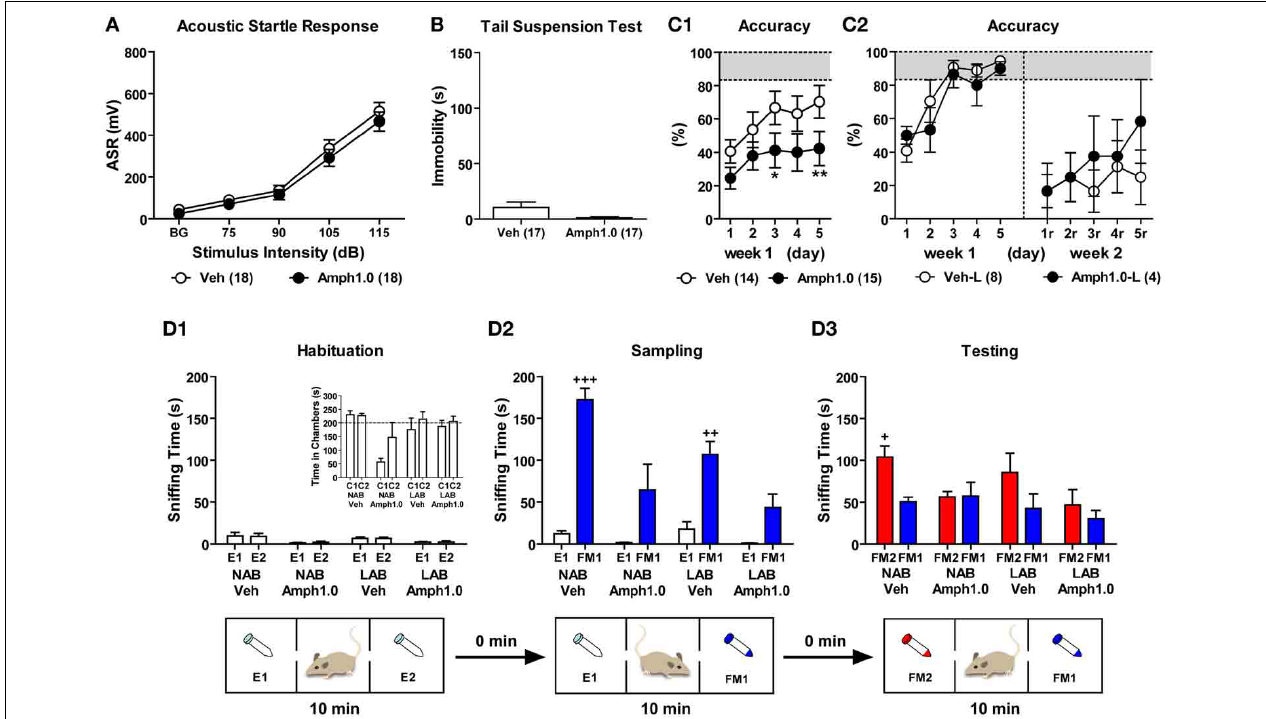
FIGURE 14 | Amphetamine failed to rescue the active coping styles and cognitive impairments in LAB mice. To evaluate the effects of amphetamine on coping styles, LAB mice were randomly assigned to control (Veh) and amphetamine (Amph) groups and were tested in the startle response test and tail suspension test. LAB-I and LAB-S were merged for analysis since the two groups did not show difference in their sensation upon the acoustic stimuli and immobility (data not shown). Results revealed that treatment with amphetamine (1.0mg/kg) did not influence (A) the startle responses and (B) immobility time in LAB mice. (C) To investigate the influence of amphetamine on spatial learning, LAB mice were trained in the WCM test with free learning protocol (cf. Figure 11 ). On each testing day 5min before the first trial, animals were treated with either saline or amphetamine (1.0mg/kg) and tested with 6 trials per day over the course of two weeks. (C1) During the first week of acquisition phase (d1–d5), the performance of learning acquisition was represented by accuracy and the treatment with amphetamine resulted in decreased levels of accuracy. (C2) Only 8/14 (57%) Veh-control and 4/15 (27%) Amph-treated LAB mice successfully acquired the test in the first week. These accurate learners